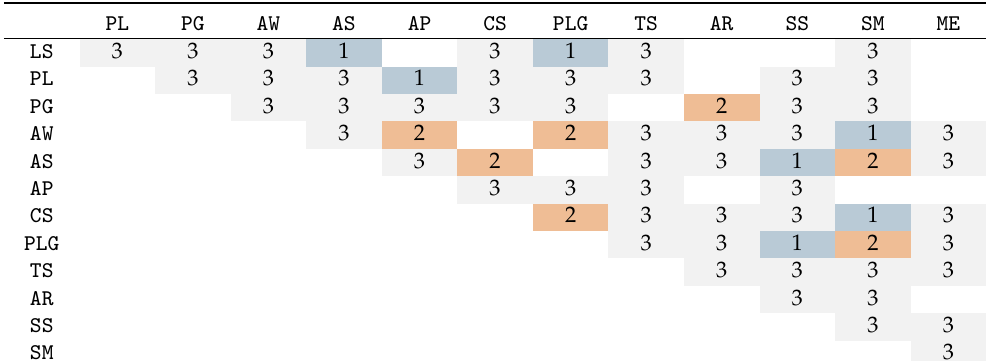
Figure 4. Interaction public area × gender. Note: Significant results are marked with asterisks (*), ρ ≤ 0.05. Standard error of means are represented. Table 4. Results of interaction public area ×